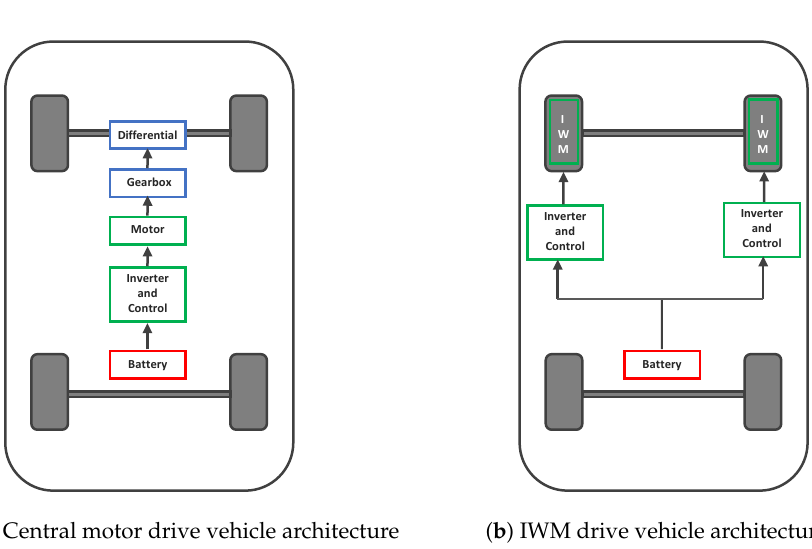
Figure 1. Vehicle architecture of ( a ) central-motor driven EV ( b ) IWM drive